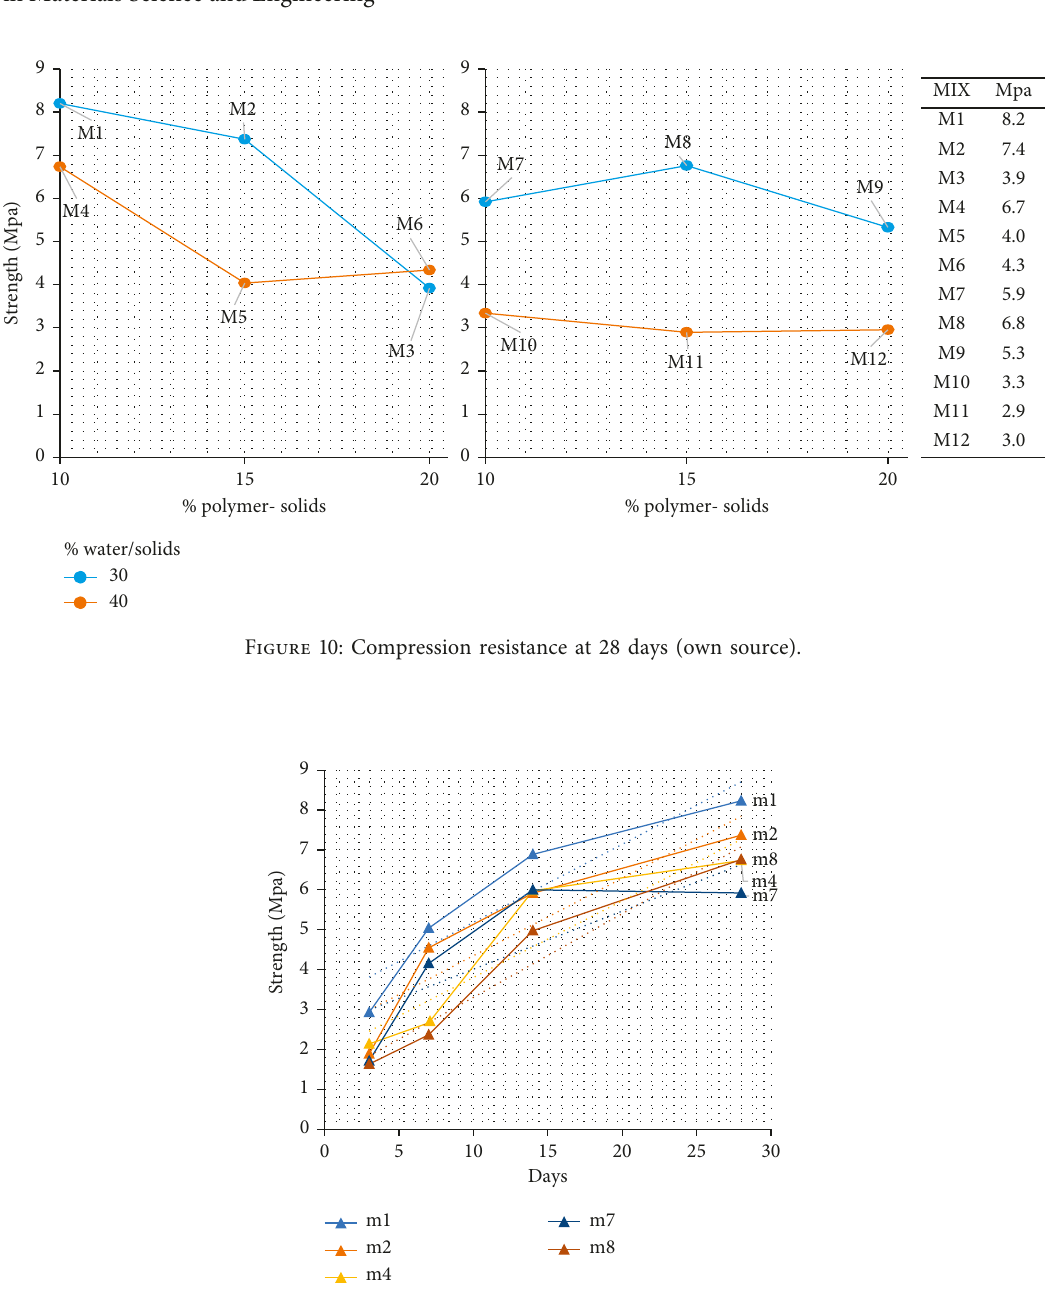
Figure 11: Most representative values and trend lines (own